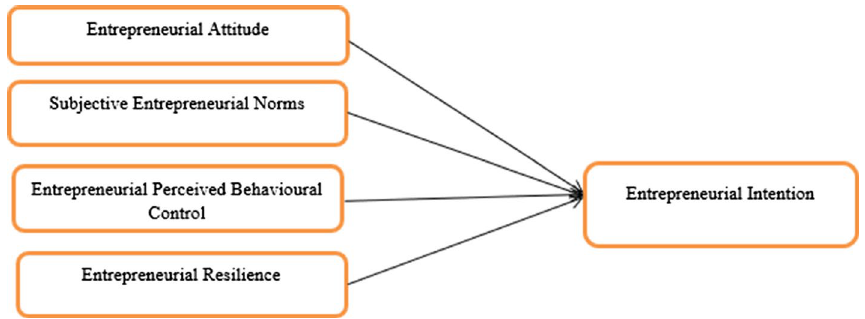
Fig. 3 Conceptual framework (adapted from Ajzan,